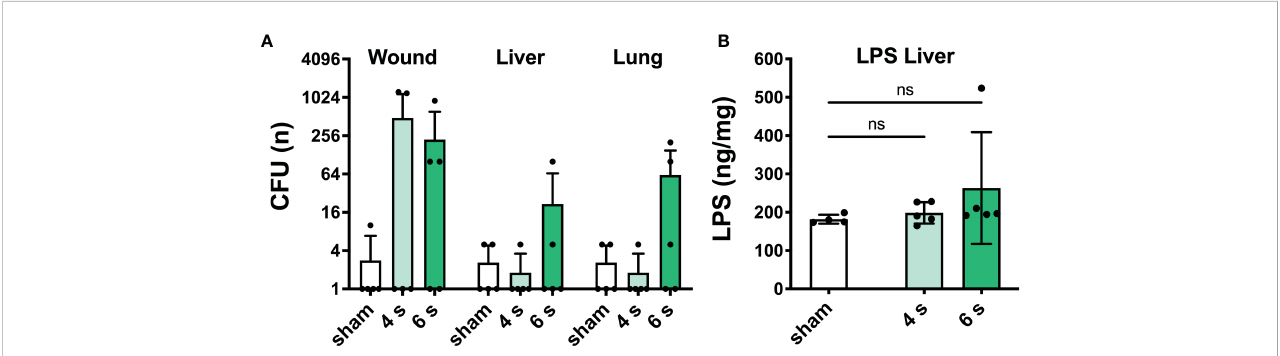
FIGURE 3 6 s scald causes systemic bacterial translocation. CFU were determined (A) in wound, liver, and lung samples. Results are provided as mean ± SD on a log 2 scale. LPS level in the liver (B) was quanti fi ed by means of ELISA. Note, translocation of viable bacteria dramatically increased in 6 s scald when compared with 4 s scald. Results are provided as mean ± SD and one-way AVONA with Dunnett ’ s correction was performed. The level of signi fi cance: ns, not signi fi cant.